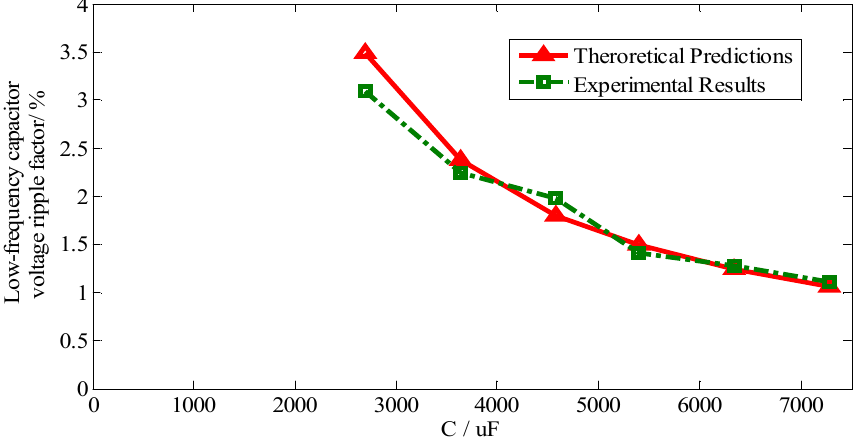
Figure 9. Experimental waveforms of DC source voltage (blue) (10 V/div), inverter output voltage (green) (25 V/div) and capacitor voltage (red) (1 V/div) (AC coupling) with different groups of L and C combinations; measured peak to peak ripple of capacitor voltage ( a ) 4.80 V, ( b ) 3.48 V, ( c ) 3.08 V, ( d ) 2.20 V, ( e ) 1.98 V, ( f ) 1.72 V;